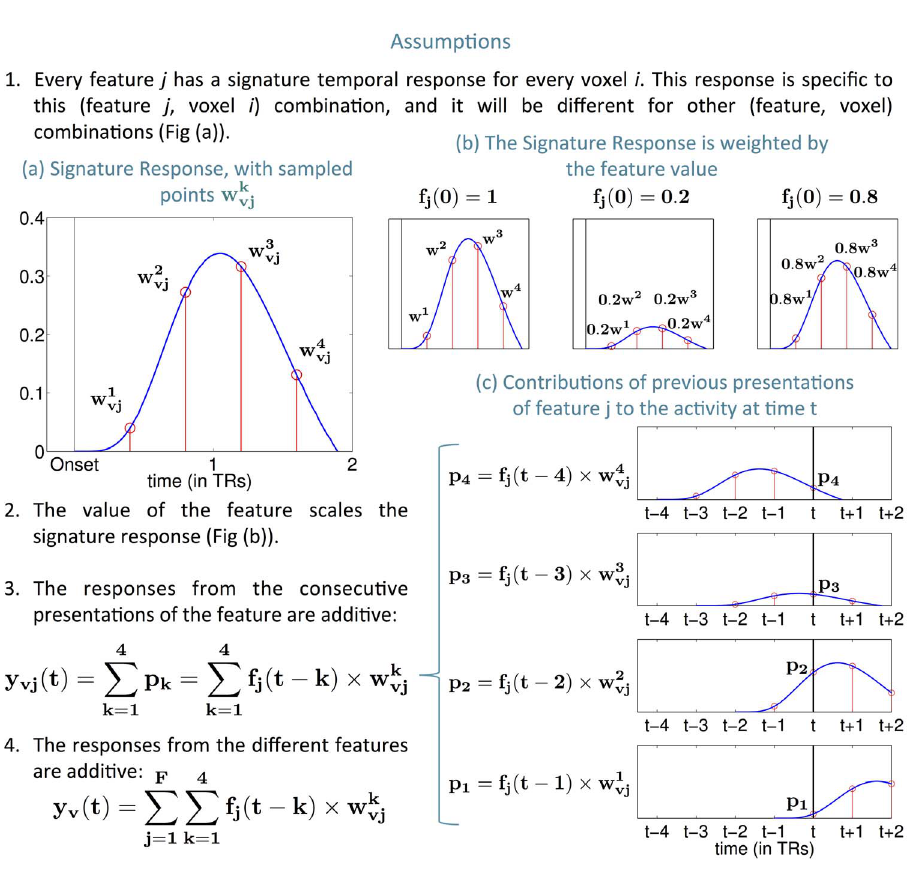
Figure 1. Time model of a voxel’s response to the consecutive occurrences of the features of a story. Because of the hemodynamic response latency, the occurrence of a feature at time t will affect the activity of the voxel for several TRs after time t. This latency is accounted for by considering occurrences of features at previous TRs when modeling a voxel’s activity at time t. (One TR is the repetition time needed to acquire one fMRI image, here we use a TR of 2